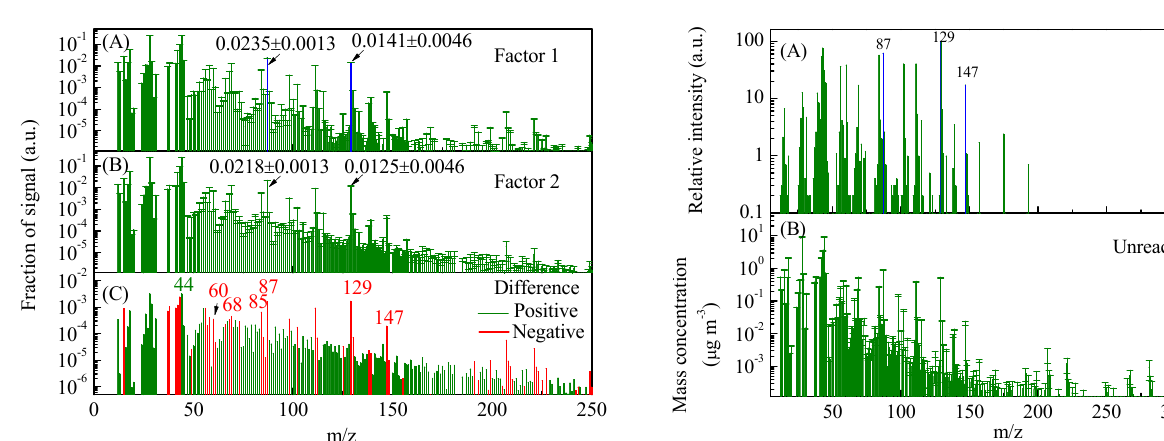
Figure 2. Normalized mass spectra of (a) citric acid (PMF factor 1), (b) citric acid oxidation products (PMF factor 2) and (c) the difference mass spectrum (factor 2–factor 1). The numbers in the upper two rows are the intensities of m/z 87 and 129, while negative values are shown in the bottom row. The red and green lines indicate a negative and positive value, respectively.